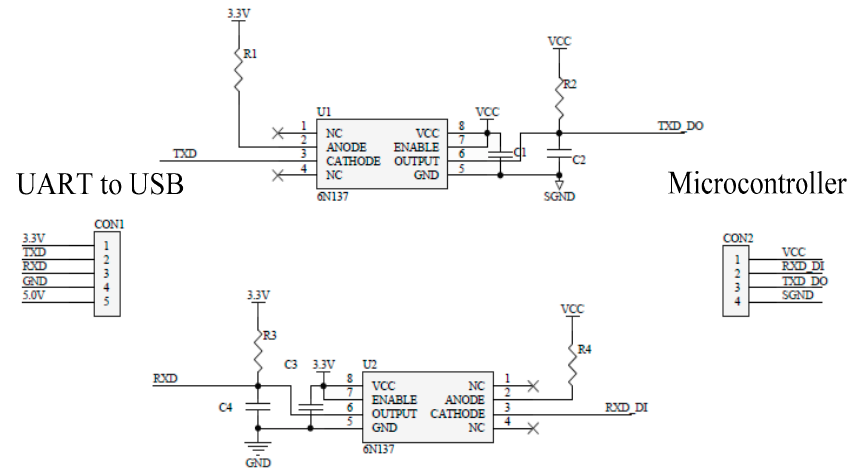
Figure 14. Circuit of signal isolation.